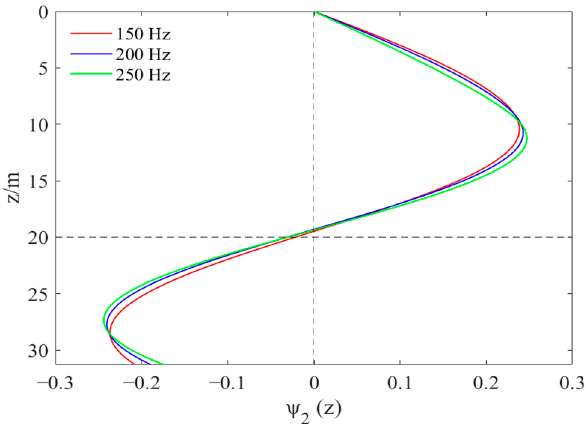
Figure 6. Calculated eigenfunctions ψ 2 ( z ) corresponding to frequencies of 150, 200, and 250 Hz (sound speed, mass density, and sound absorption of the bottom are adopted as 1700 m/s, 1.8 g/cm 3 , and 0.1 dB/ λ , respectively).